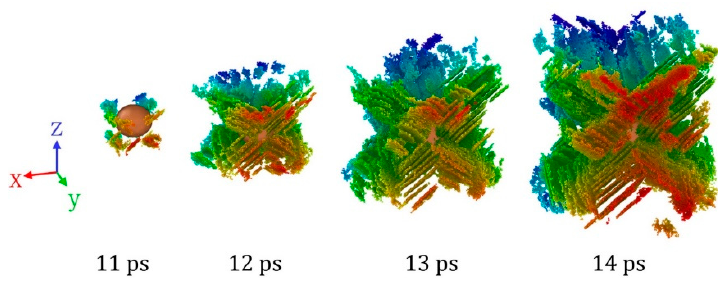
Figure 6. Dislocation and stacking fault structure near Cu inclusions at different times when u p = 1.5 km/s. The atoms are rendered by Y positions to enhance the stereoscopic effects.